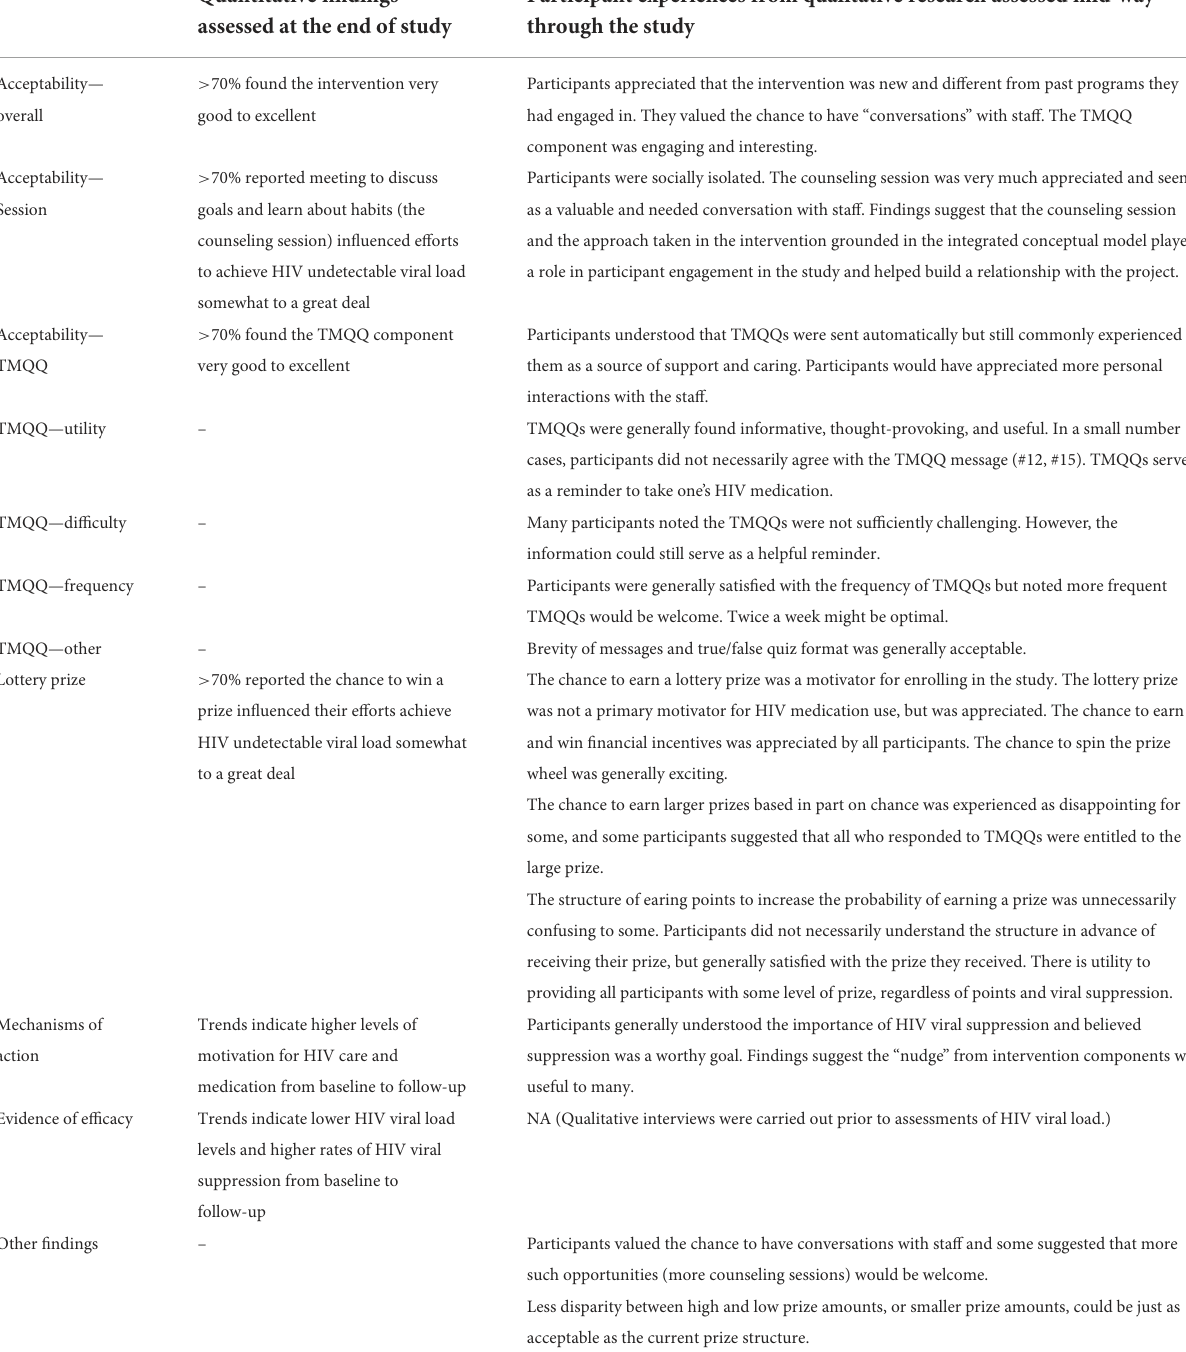
TABLE 8 A joint display organized by the primary research questions and including emergent findings. Quantitative